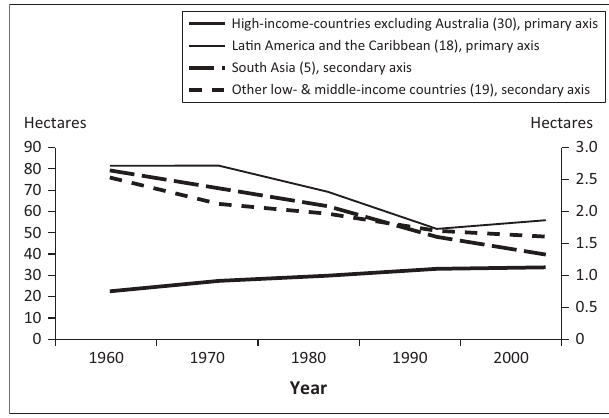
FIGURE 1: Average farm sizes,